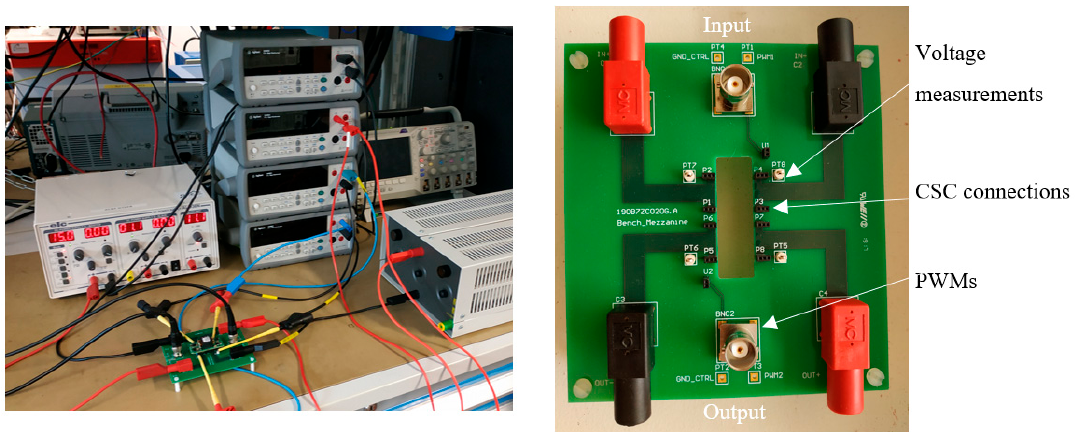
Figure 4. Picture of the characterization board, together with the instrumentation required to carry out CSC testing.